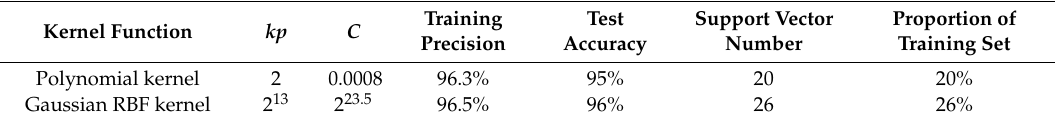
Table 5. Statistics of the SVM classifier parameter